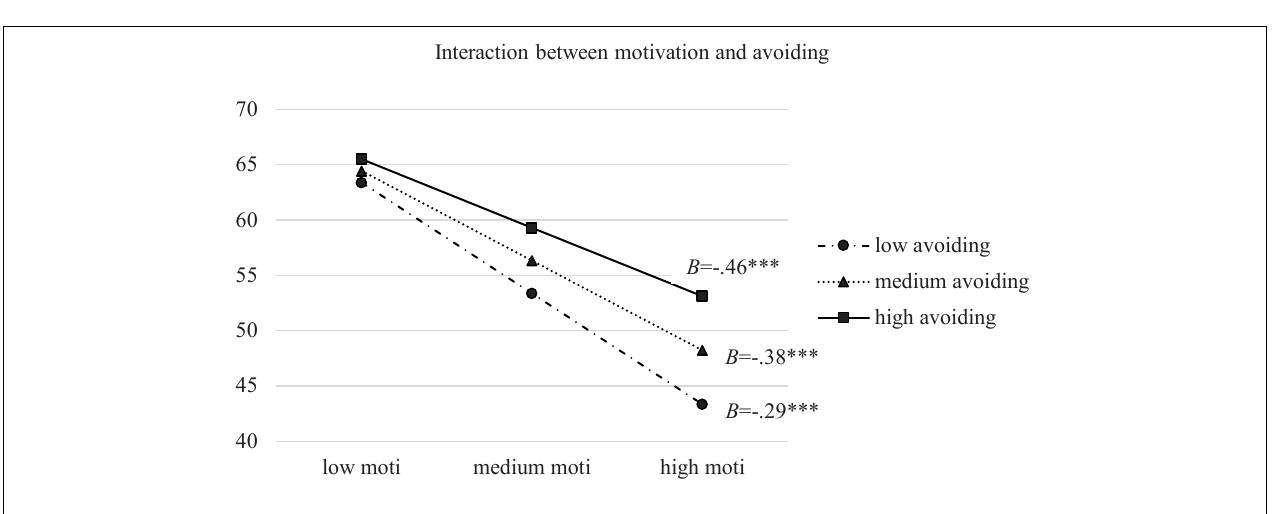
students since interpersonal harmony and interdependence